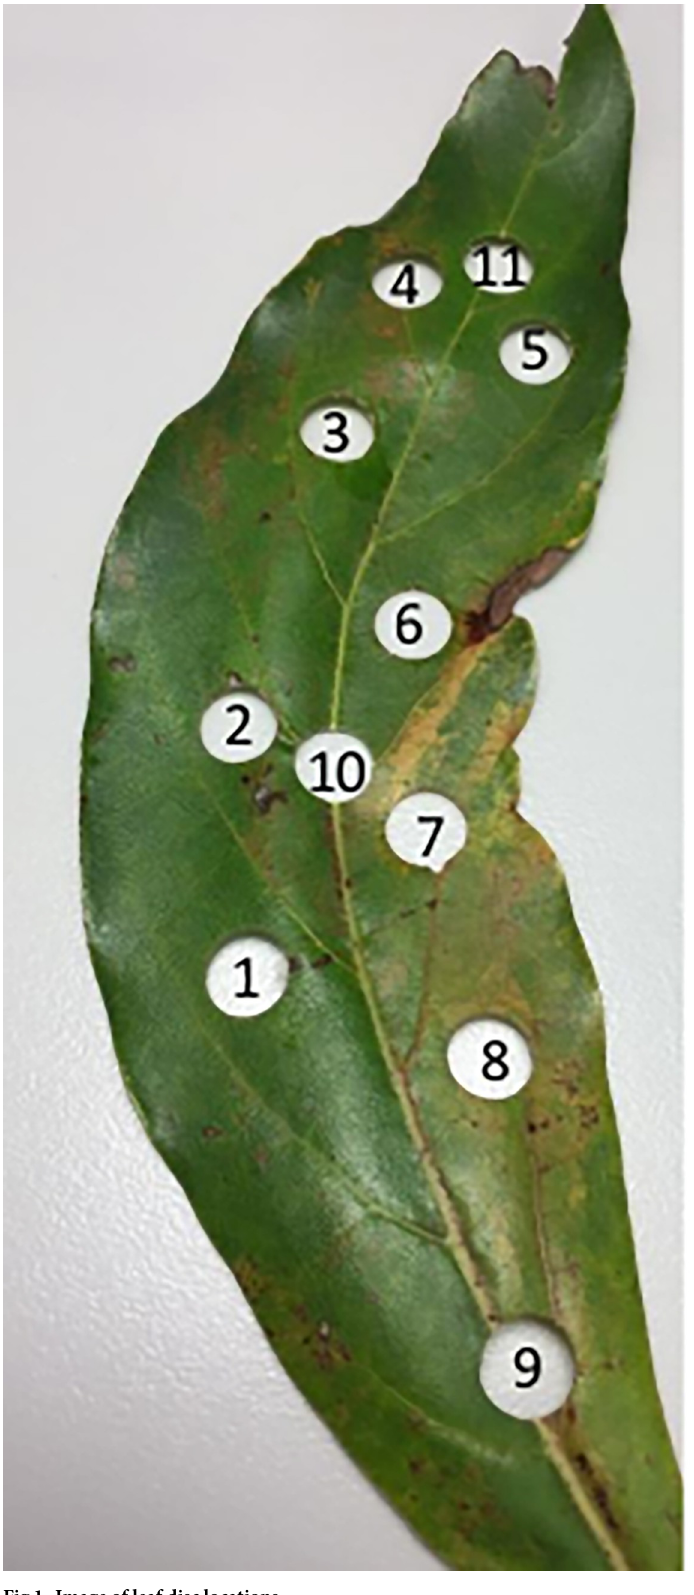
Fig 1. Image of leaf disc